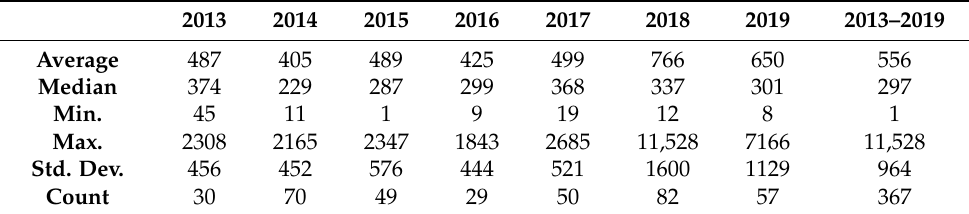
Table 2. Descriptive statistics for Market Value (USD millions) as of the end of the IPO